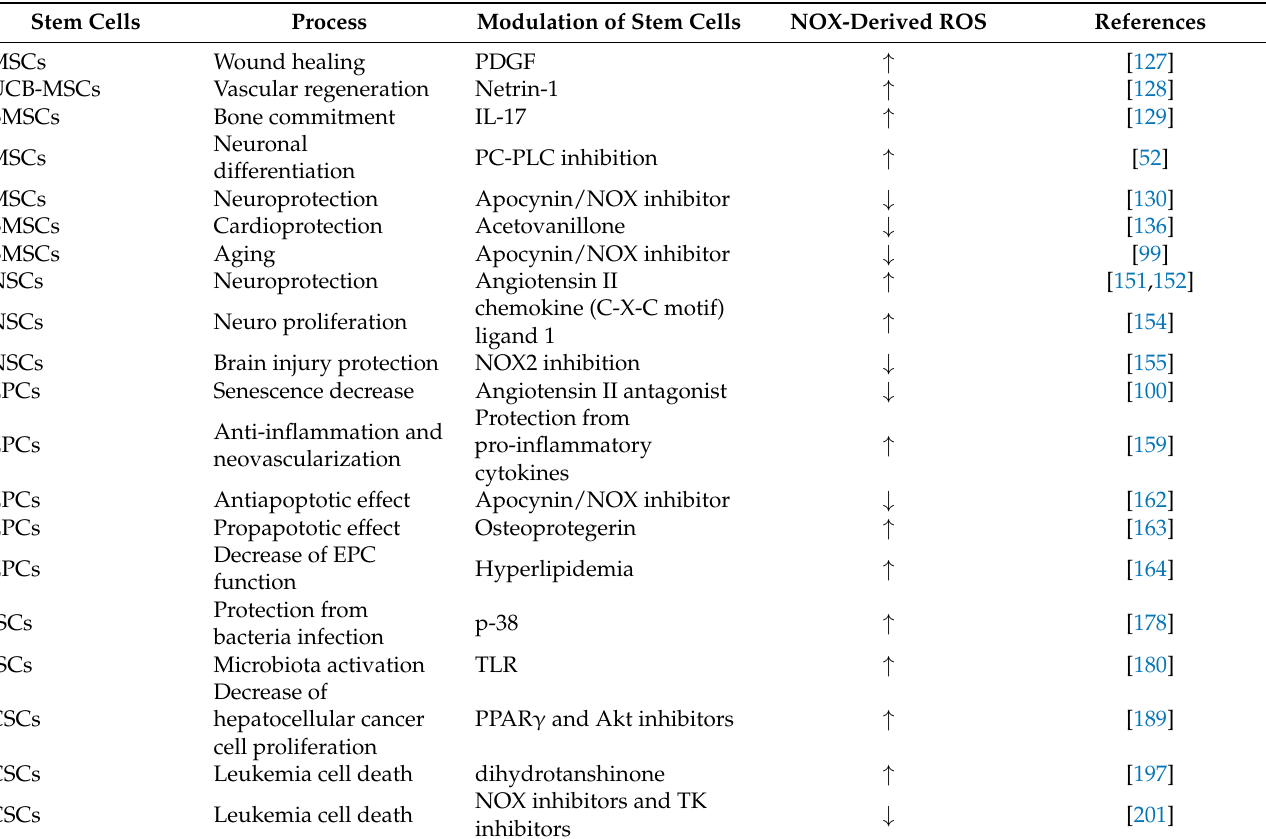
Table 1. Nox modulation in stem cells as a potential strategy for the treatment of different pathologies. Stem